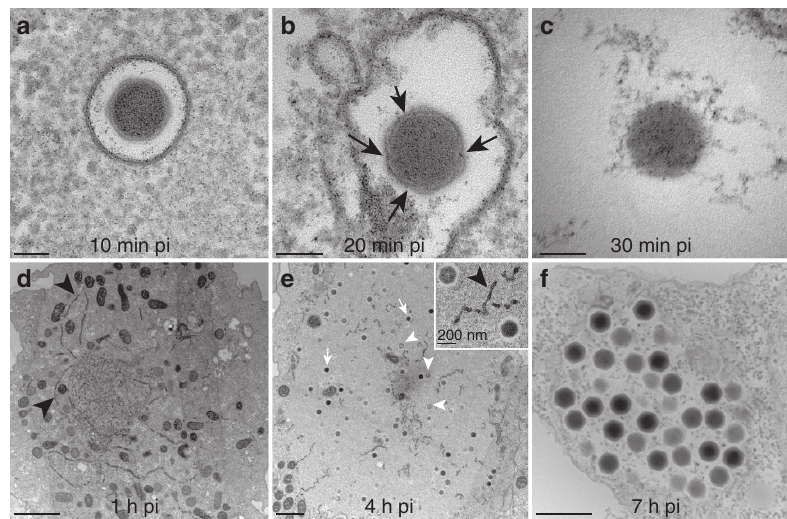
Figure 1 | Ultrathin-section TEM imaging of Noumeavirus-infected Acanthamoeba cells. ( a ) 10min pi, virions have been engulfed and are in vacuoles. ( b ) 20min pi, virions in vacuoles exhibit holes (black arrows) in their external translucent shell and appear more spherical. ( c ) 30min pi, virions have entirely lost their external shell and appear as spherical electron-dense nucleoids, which can be seen in vacuoles as well as in the cell cytoplasm (and Fig. 9, black arrows). Scale bar, 100nm. ( d ) 1h pi infected cells. Electron-dense tubular structures (black arrowheads) appear in the cell cytoplasm. ( e ) 4h pi viral